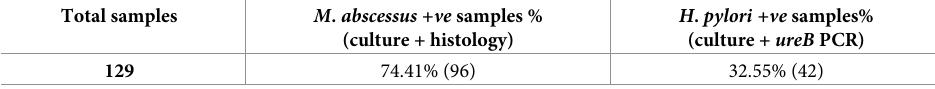
Table 3. Prevalence of M . abscessus and H . pylori in the stomach of patients with various gastric diseases. Total samples